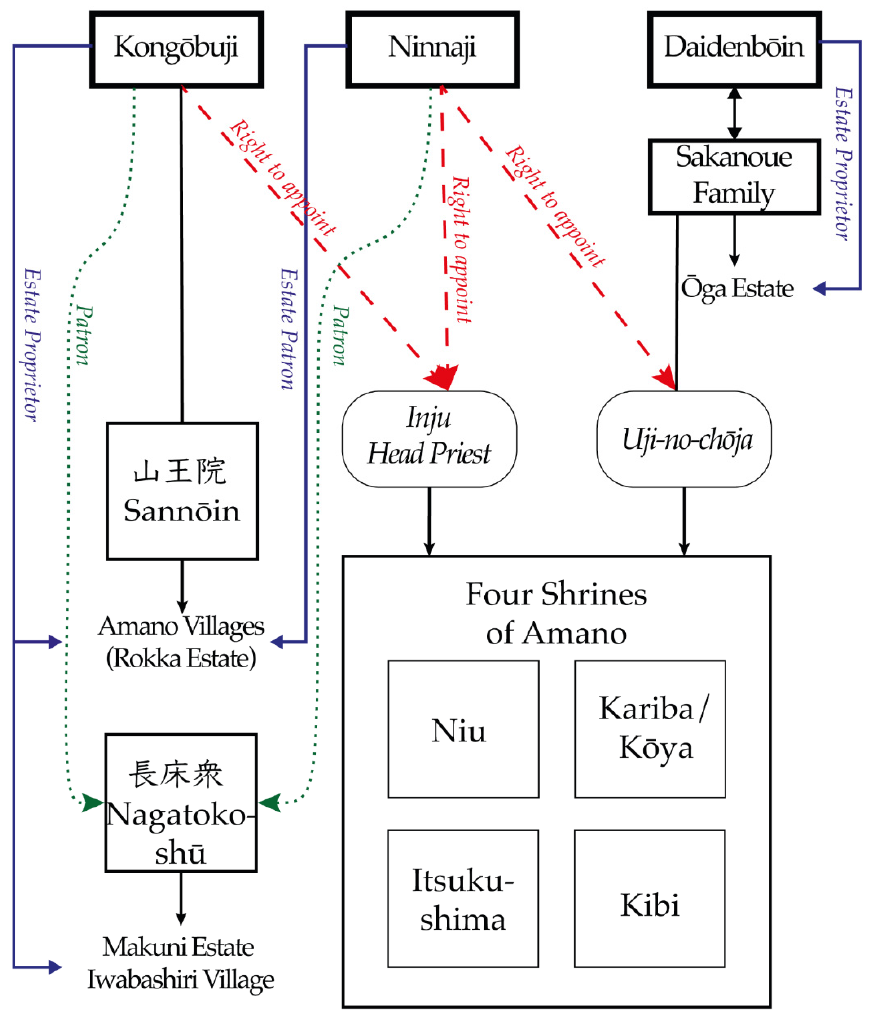
Figure 1. Institutional Relationships at Amano in the Thirteenth Century.